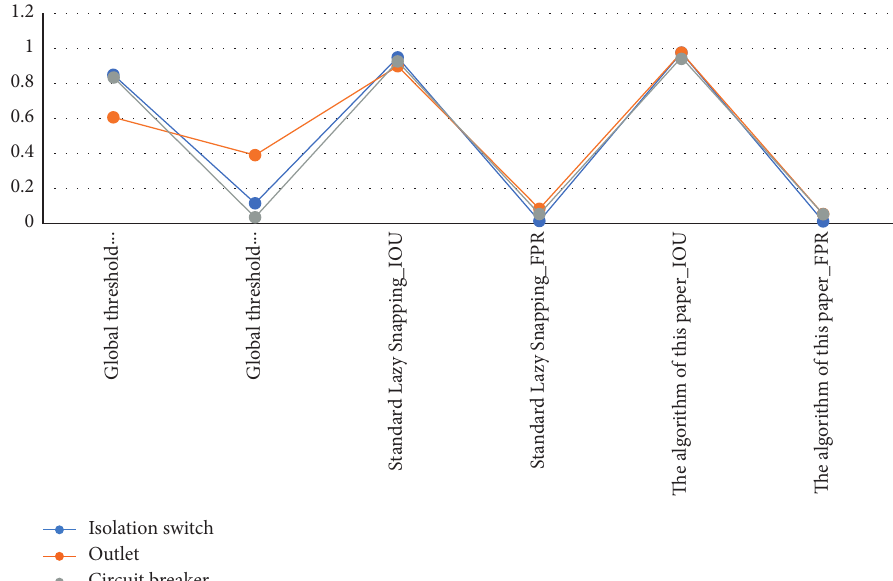
Figure 4: Segmentation effects of various types of infrared